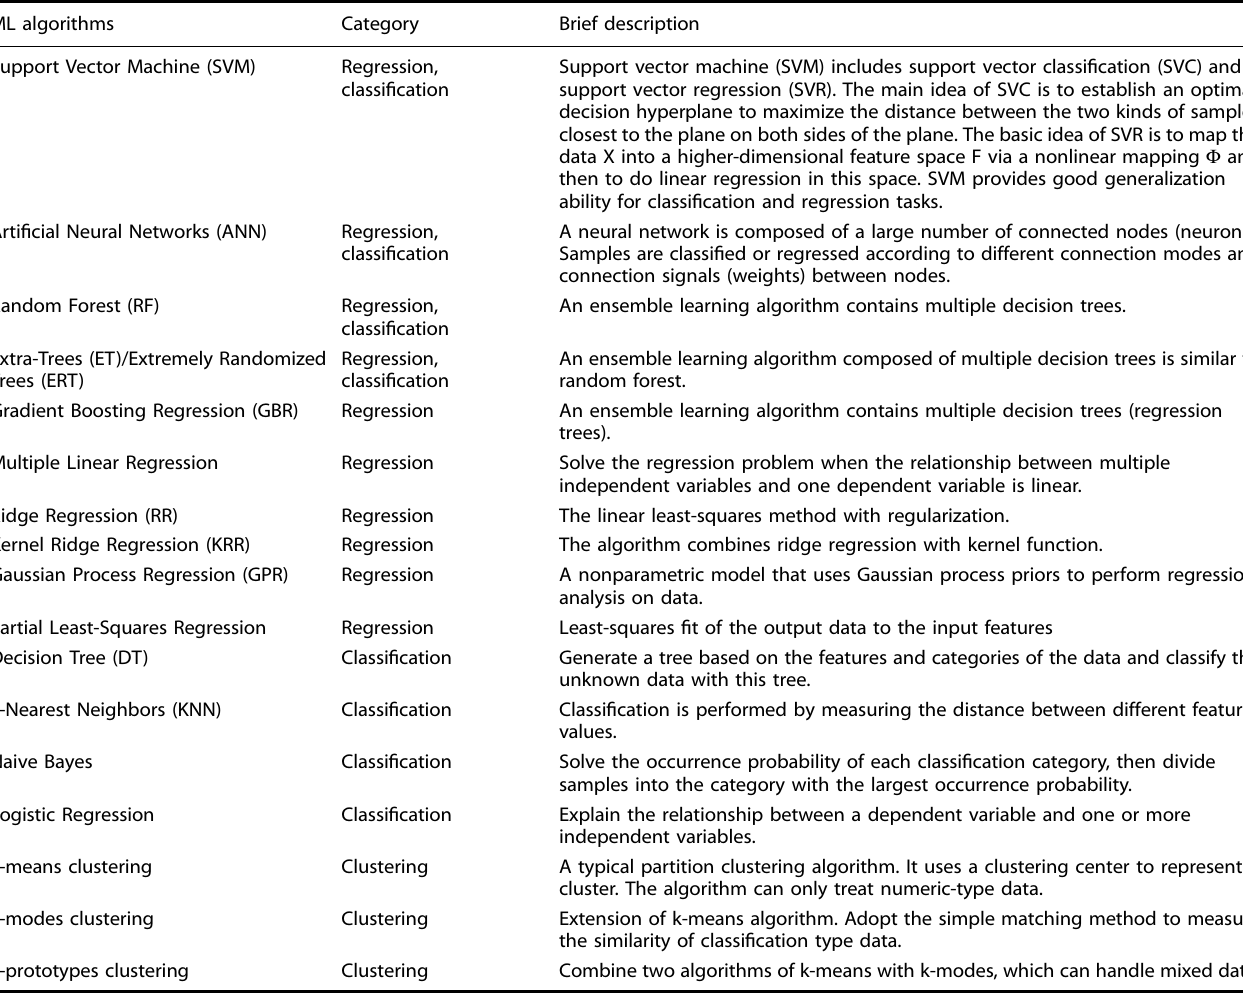
Table 2. Common ML algorithms in material